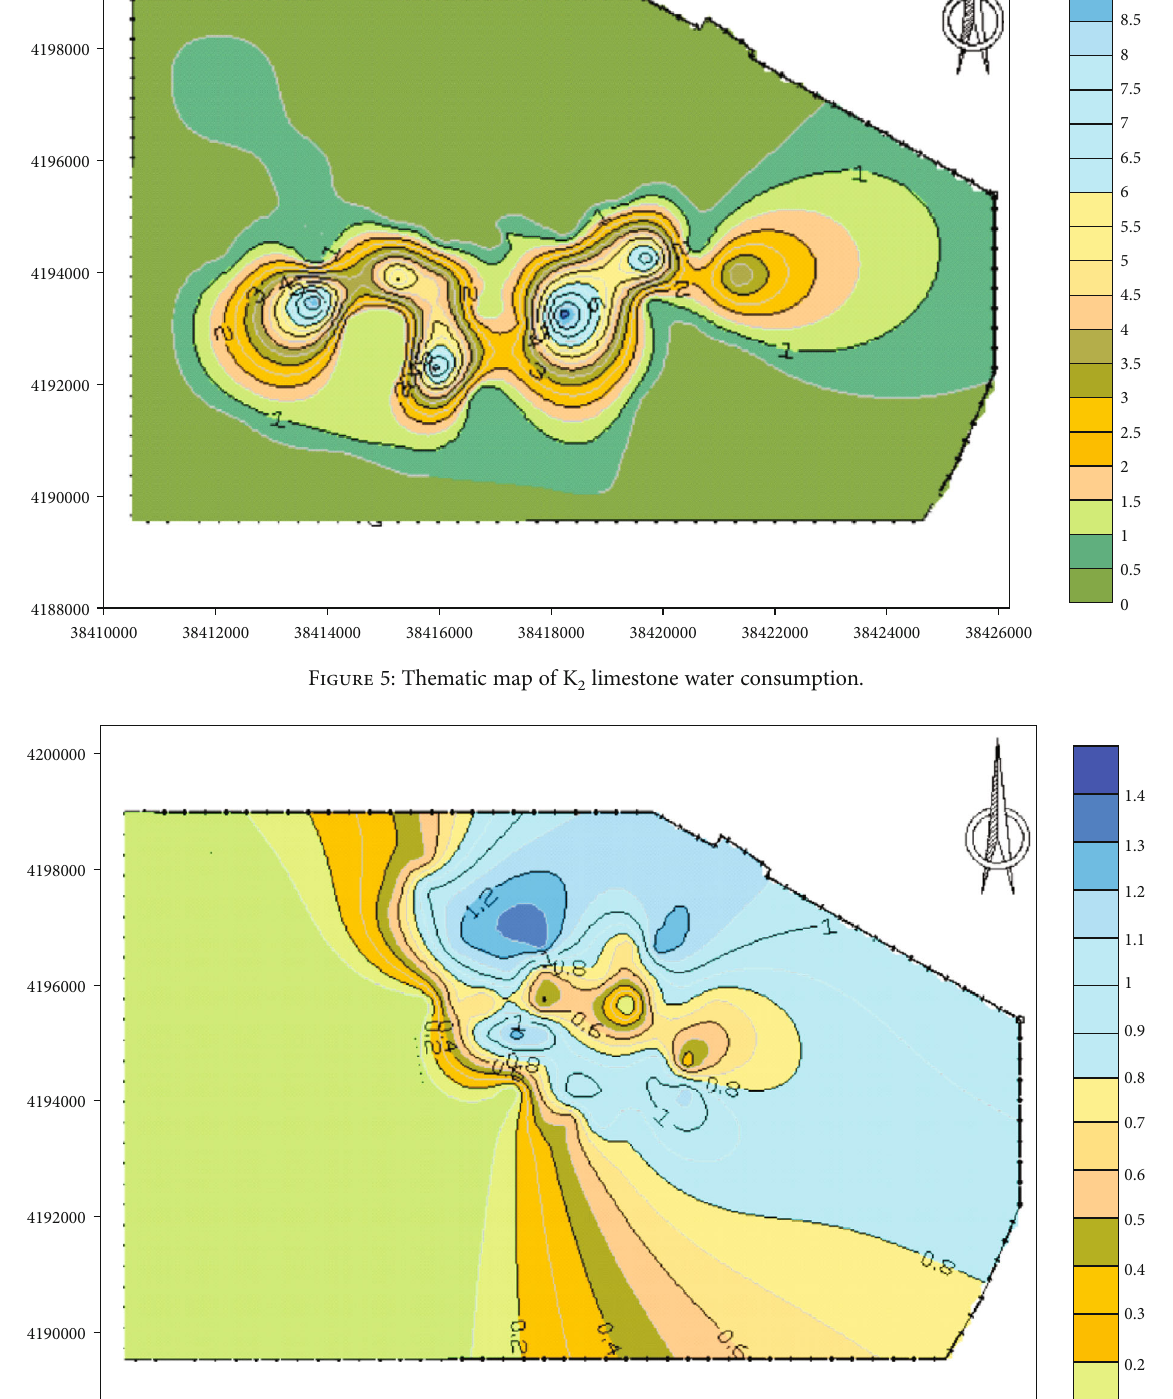
Figure 6: Thematic map of the fault fractal dimension